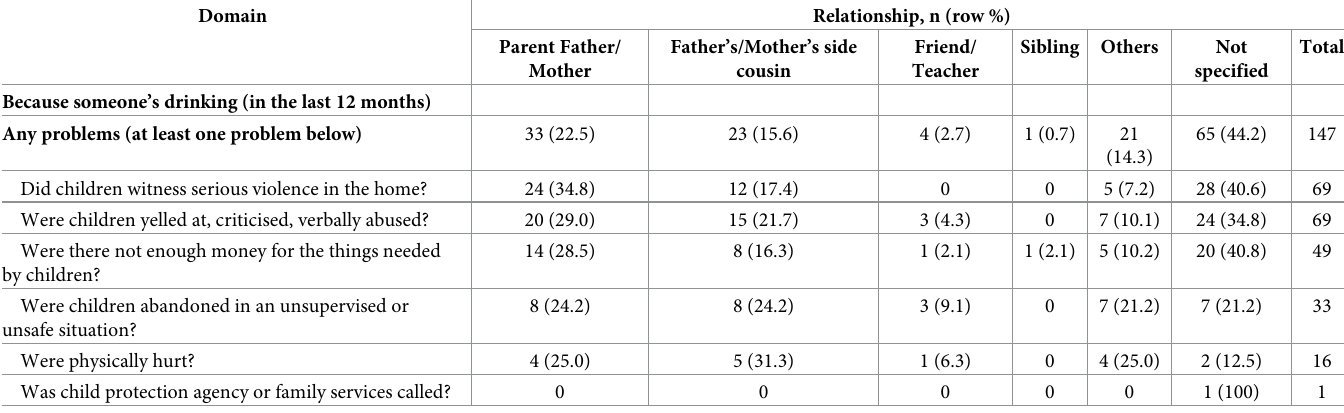
There were no significant differences in the participants between the two groups, except for age and the presence of a binge or frequent drinker in the household (Table 3) . The children around the younger participants had a higher probability of being exposed to alcohol related violence than those around older participants. Furthermore, there was a higher prevalence of binge drinkers (93.9% vs. 70.2%), monthly or less drinkers (28.6% vs. 26.3%), and weekly drinkers (25.2% vs. 16.5%) in those who had alcohol-related harms in their households vs. those who didn’t. Table 2. The relationship between number of identified alcohol-related harm and relationship.